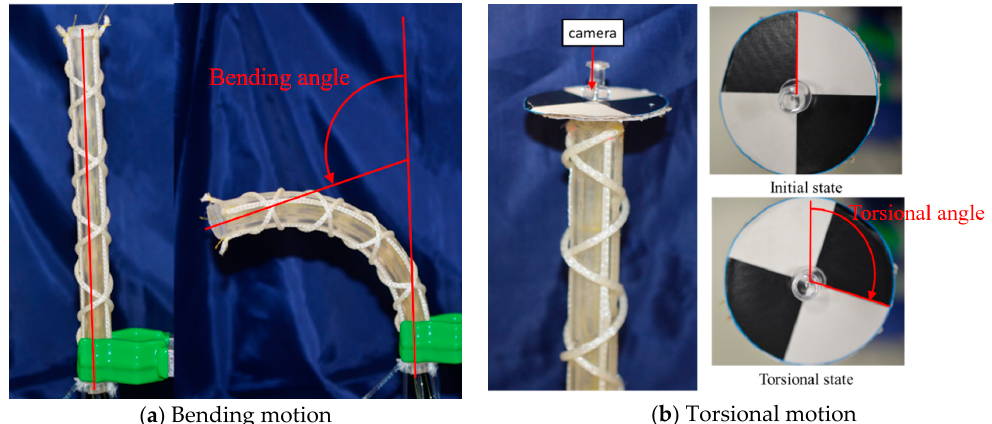
Figure 8. The motion of the soft robot arm: ( a ) Bending motion. ( b ) Torsional motion.